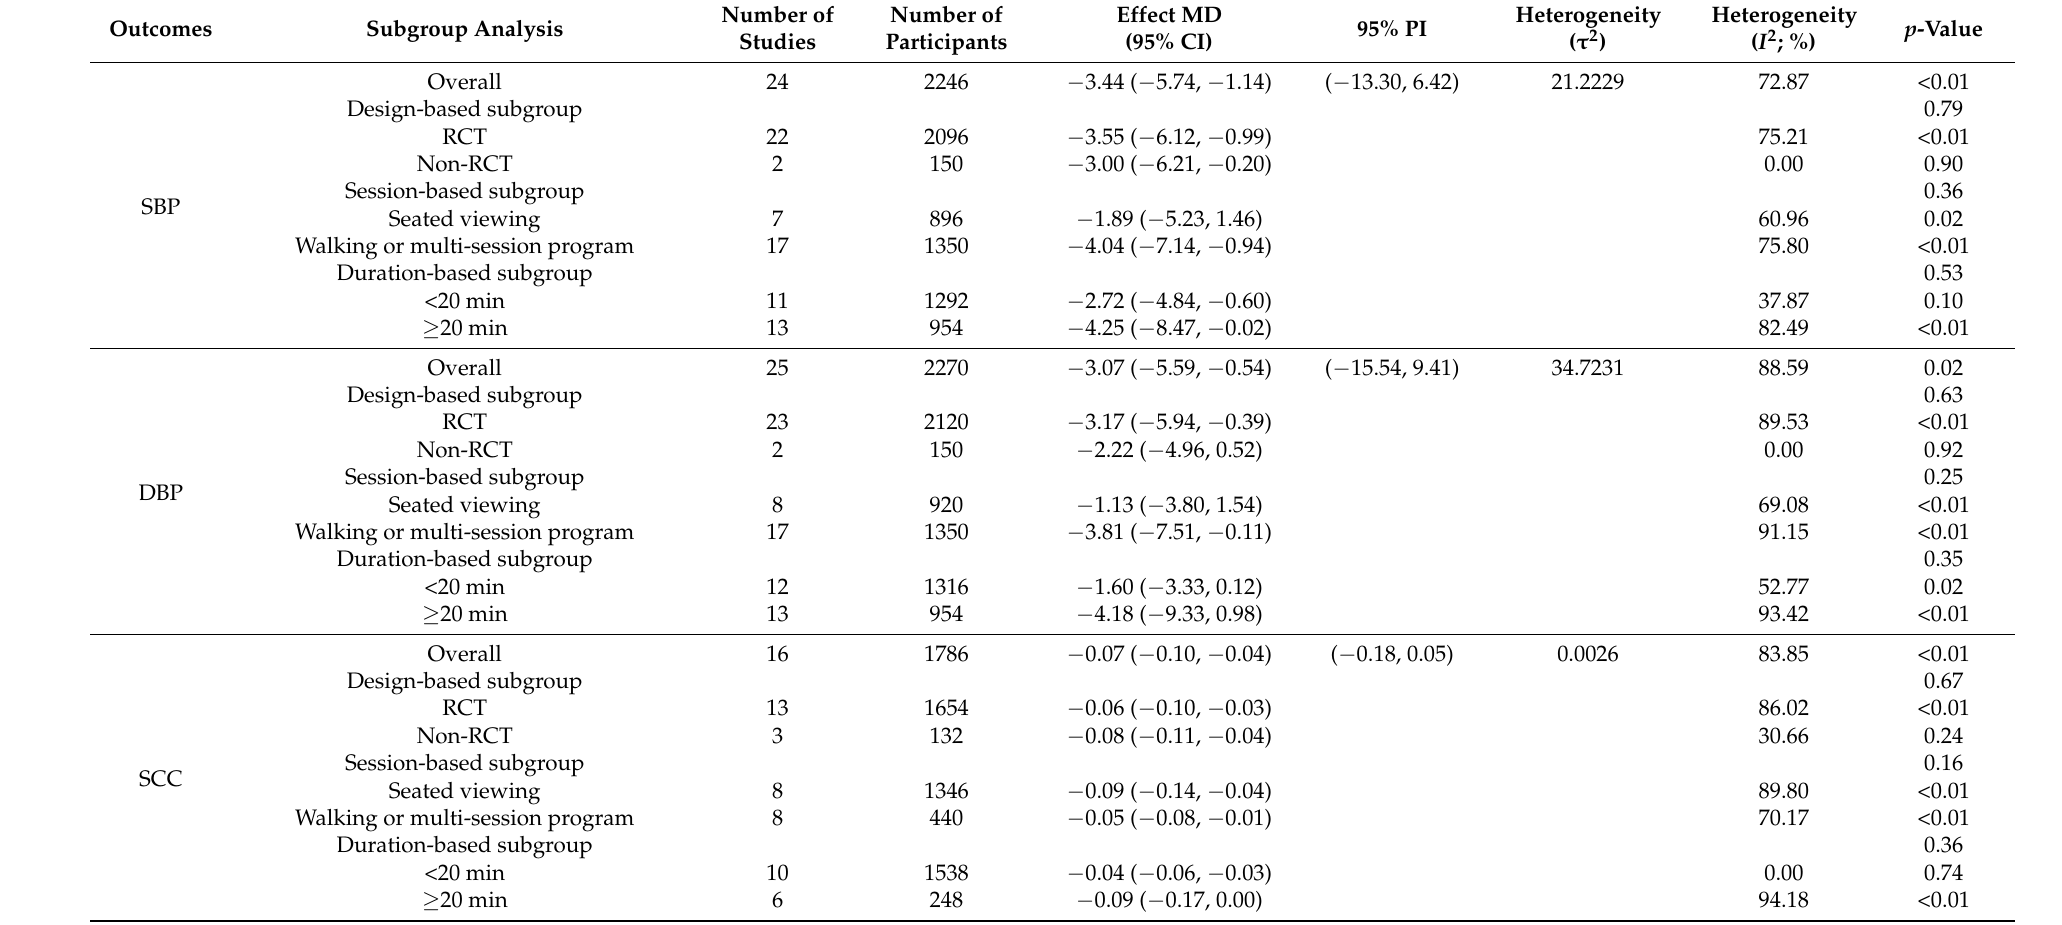
Table 3. Summary meta-analysis result of the mean difference (MD) between forest therapy and urban control groups. CI: Confidence interval; PI: Prediction interval; I 2 : I-squared statistics; τ 2 : Tau-squared